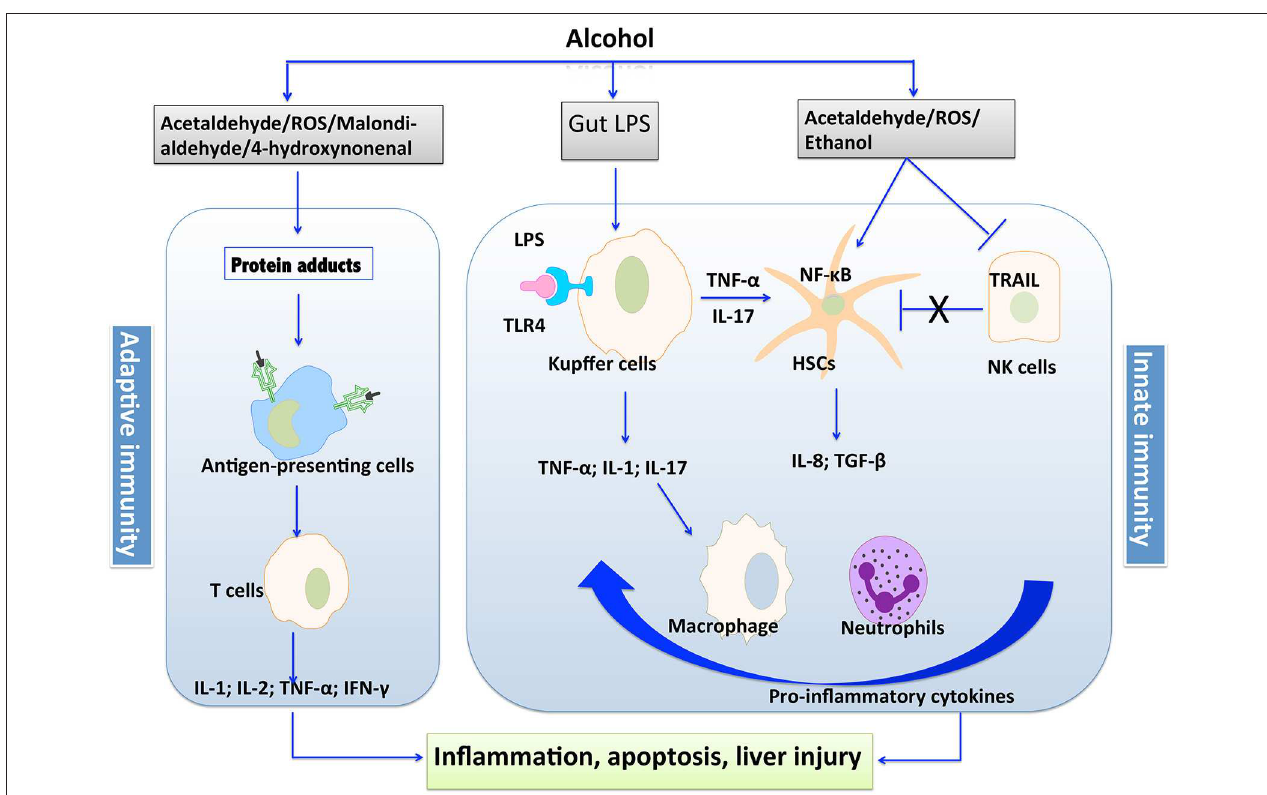
FIGURE 1 | The process of immunologic priming induced by